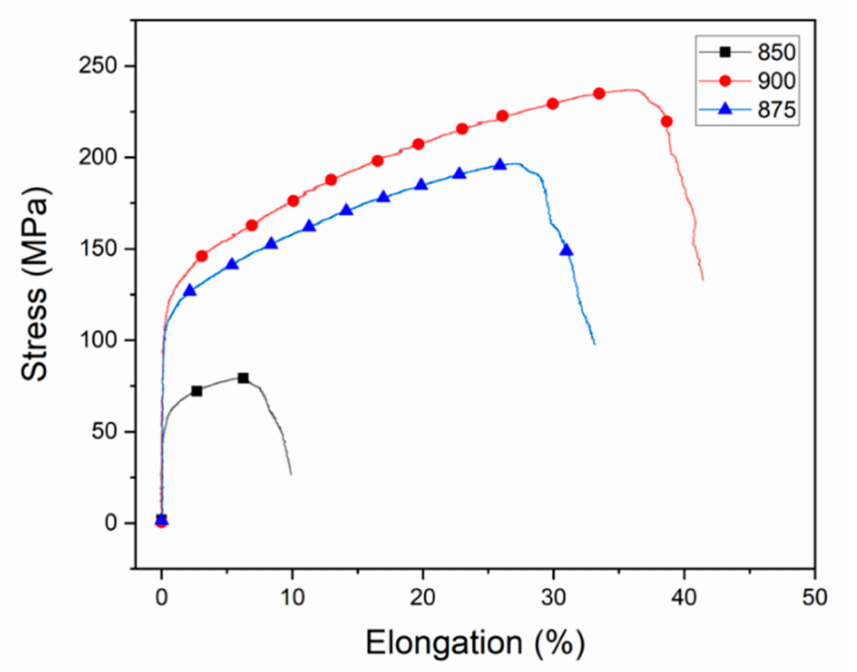
Figure 11. Stress-strain curves of sintered bronze